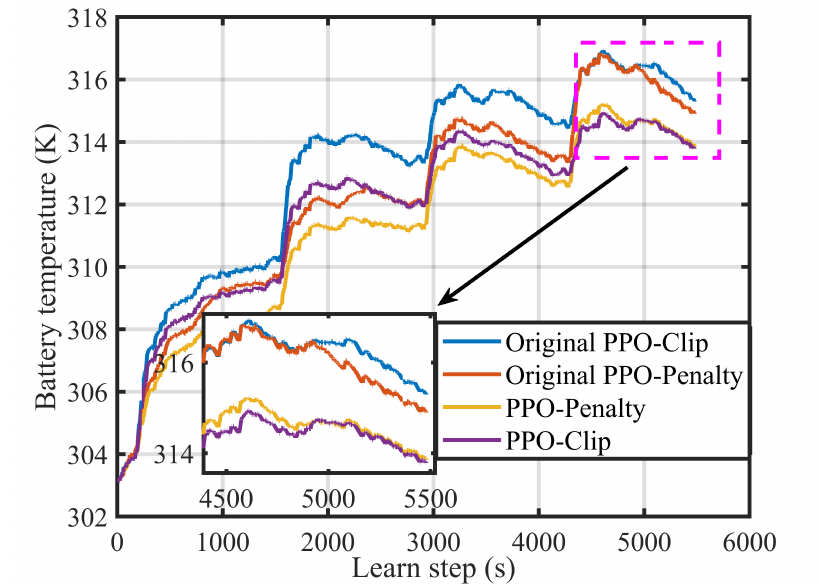
Figure 11. Battery temperature rise curves with PPO algorithms in 4 ×